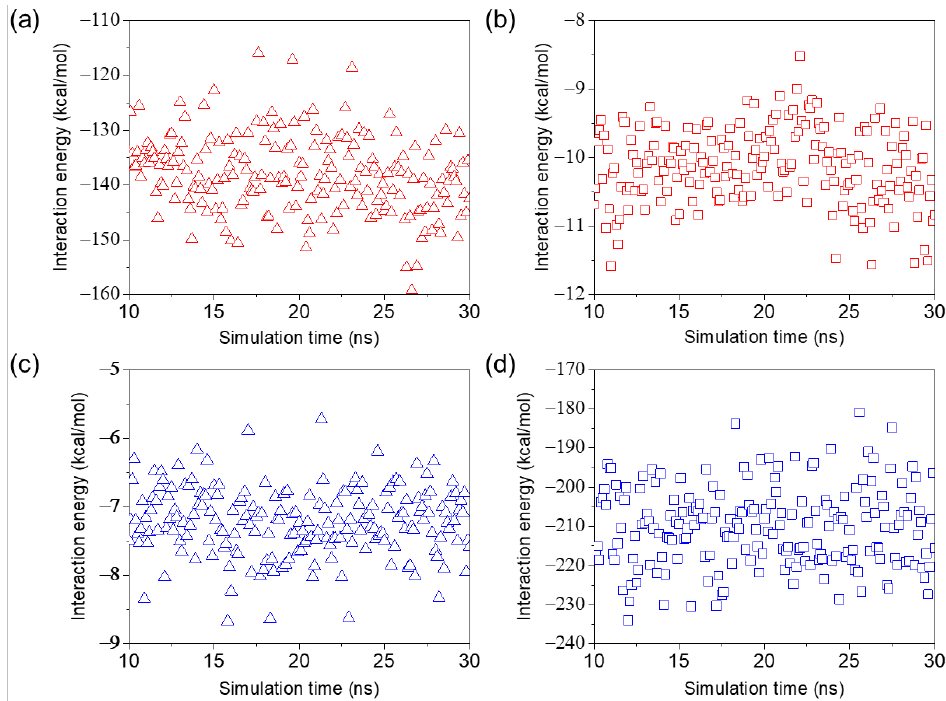
Figure 5. Interaction energy between ( a ) BMI + , ( b ) PF 6 − and negatively charged MoS 2 electrode. Interaction energy between ( c ) BMI + , ( d ) PF 6 − and positively charged MoS 2 electrode.